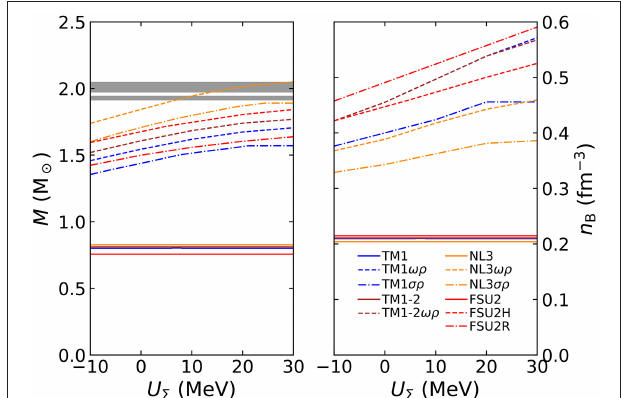
FIGURE 6 | (Right) Onset density n DU of the DU process for models in which the DU process turns on in NSs, as a function of the 6 potential at saturation density. (Left) corresponding NS masses. All models considered include